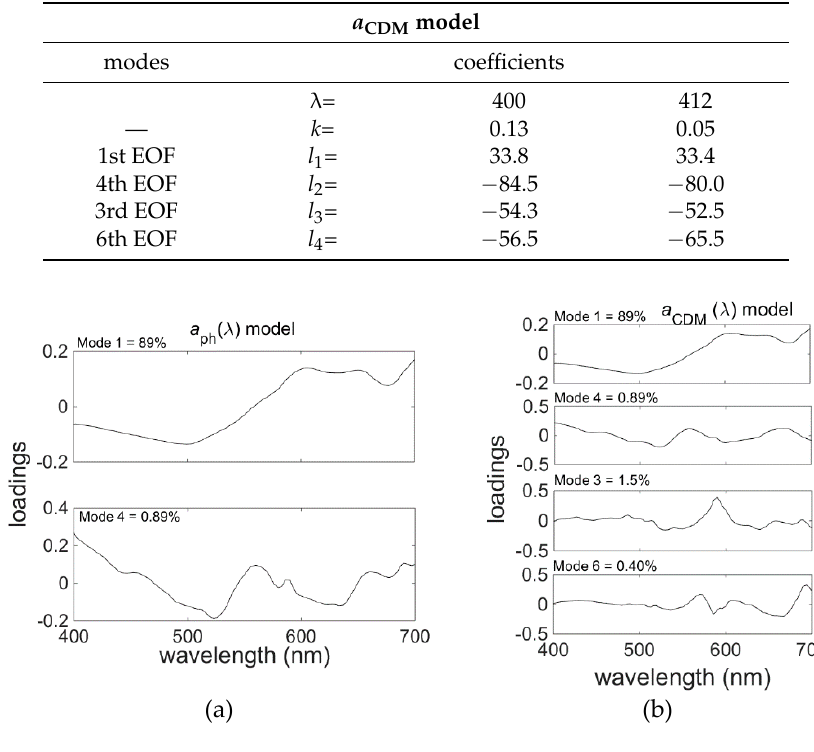
Figure 11. EOF loadings versus wavelength for the a ph ( a ) and a CDM ( b ) models showing the percent contribution to the total variance in R rs . Modes are shown in order of being included in the model with increasing p -value. Table 9. Statistics of EOF models for phytoplankton and CDM absorption coefficients for chosen wavelengths. Size N = 62 and N = 38 for aph and aCDM, respectively. Units are log 10 (m − 1 ). Ratio and MPD are dimensionless.